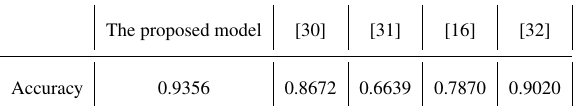
Table 5. Accuracy benchmark of our proposed model and that of existing studies The proposed